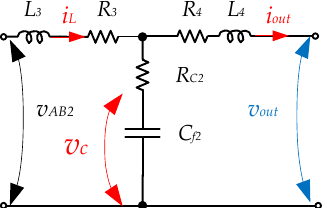
Figure 5. The dynamic model of the secondary side part of the ER used for